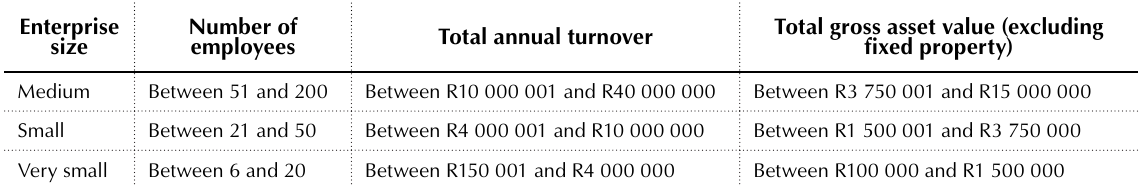
Source: South Africa